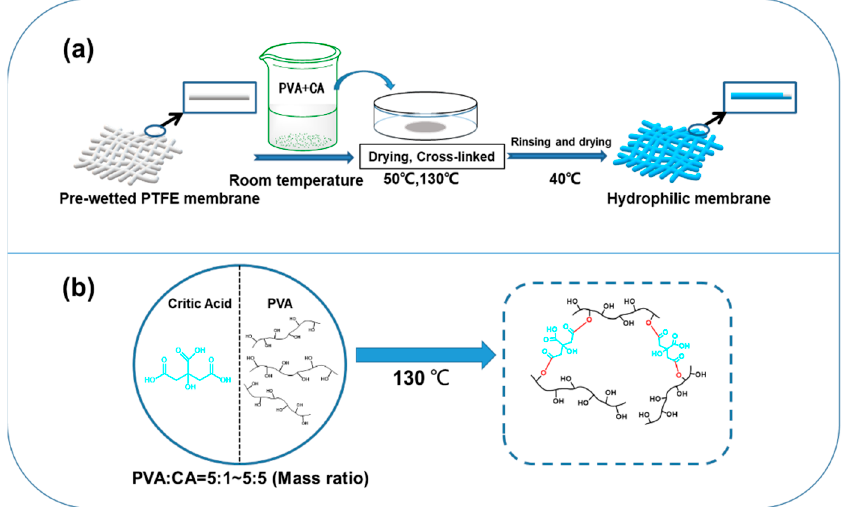
Figure 1. ( a ) The illustration of a hydrophilic modification of the PTFE microfiltration membrane. ( b ) The scheme of the green cross ‐ linking mechanism of PVA and CA at 130 °C. ( b ) The scheme of the green cross-linking mechanism of PVA and CA at 130 ◦